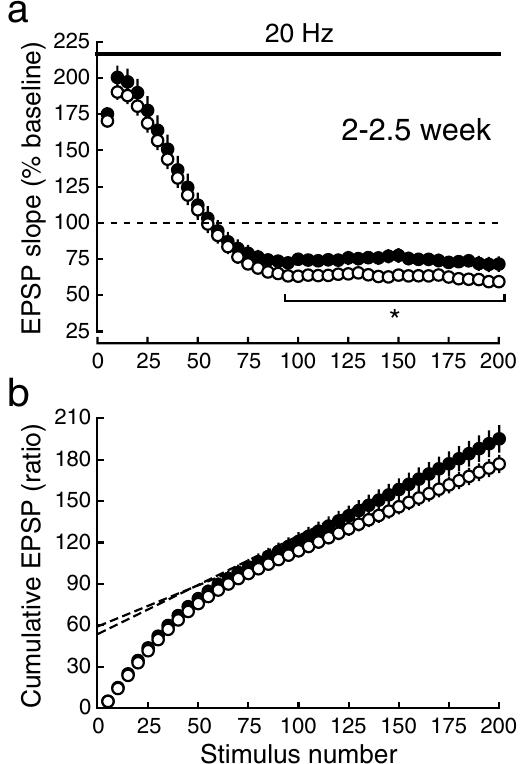
Figure 7. Synaptic responses during higher-frequency repetitive stimulation in juvenile mice. ( a ) The time course of EPSPs during 20-Hz trains in CA1 synapses in juvenile WT (open circles: ○ ) and KI (closed circles: ● ) mice. During 20-Hz stimulation, the depression of EPSPs in the early phase was similar in WT and KI mice. In contrast, the steady-state responses in the late phase were significantly larger in KI mice compared with WT mice. ( b ) The cumulative plot of EPSP amplitudes during 20-Hz trains, which were normalized to those of the baseline EPSP, is shown. The broken lines represent the regression lines fitted to the last 10 points (from the 191st to the 200th pulse) of EPSPs in KI (closed circles: ● ) and WT (open circles: ○ )